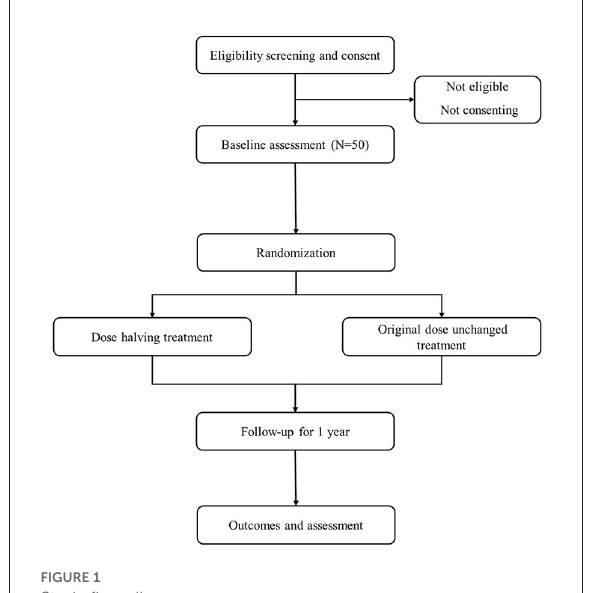
FIGURE1 Study flow